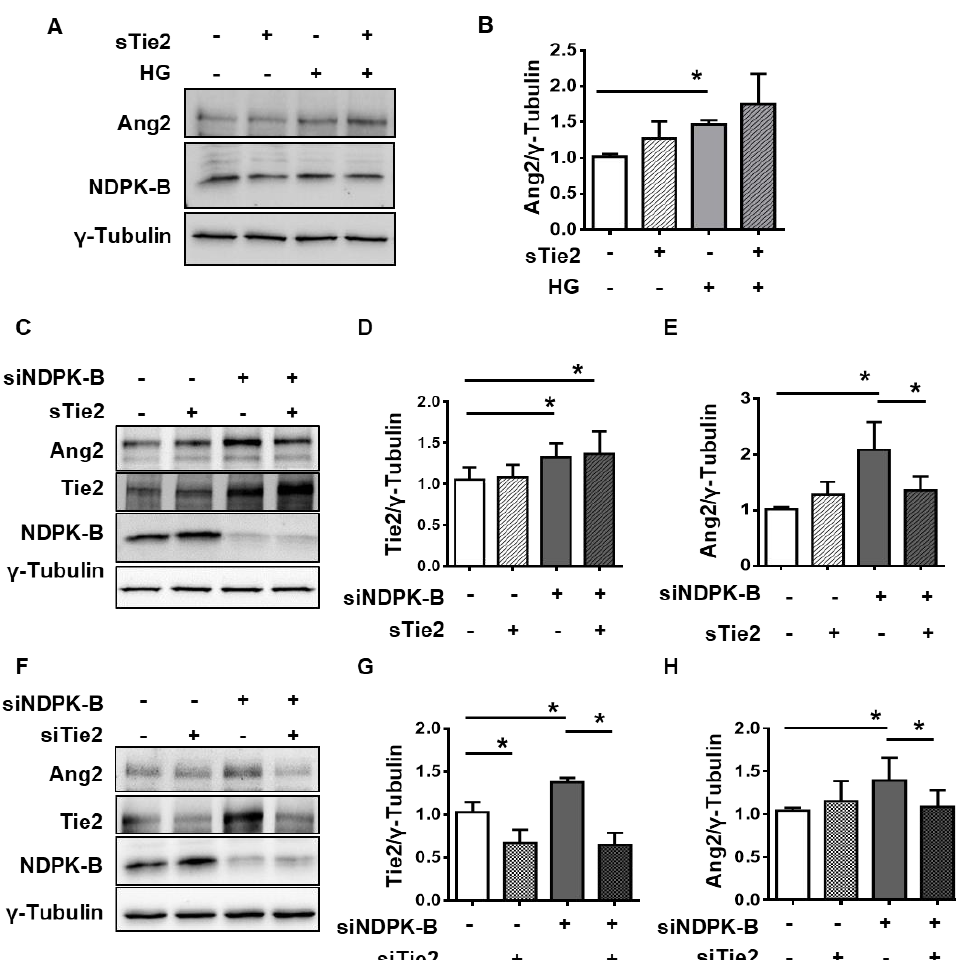
Figure 5. Tie2 is required for NDPK-B depletion- but not HG-induced Ang2 upregulation. HUVECs were transfected with either scrambled control ( − ) or siRNA against NDPK-B (siNDPK-B, + ), treated without ( − ) or with HG ( + ) and without ( − ) or with soluble Tie2 (sTie2, + ) for 24 h. ( A , C ) Representative immunoblots for Ang2, NDPK-B, Tie2, and γ -Tubulin as indicated. ( B ) Quantification of Ang2 normalized to γ -Tubulin in HG and sTie2 treated cells ( n = 4). Quantification of Ang2 ( D ) and Tie2 ( E ) normalized to γ -Tubulin in NDPK-B-depleted and sTie2 treated cells, ( n = 4). HUVECs were transfected with either scrambled control ( − ) or siRNA against NDPK-B (siNDPK-B, + ) or Tie2 (siTie2, + ). ( F ) Representative immunoblots for Ang2, Tie2, NDPK-B, and γ -Tubulin in cells depleted of NDPK-B and Tie2. Quantification of Tie2 ( G ) and Ang2 ( H ) normalized to γ -Tubulin ( n = 4). * p < 0.05.